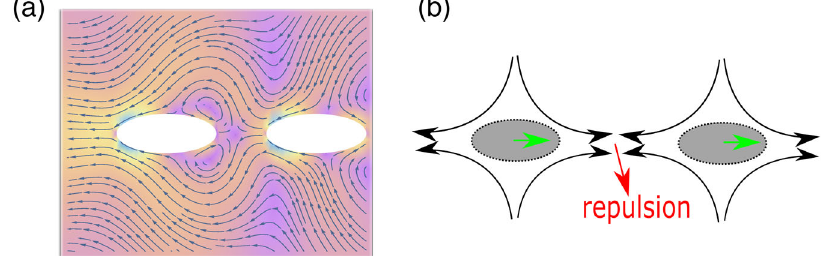
Fig. 8 Two swimmers in VELC, launching with the same initial orientation α = 0. Two pushers ( β = − 2) with planar anchoring ( W = 0.5) swim in VELC. Both of their initial orientation is α = 0. Coupling parameter χ = − 0.03. a Fluid velocity fi eld v ( x ) around the swimmers. b Sketch of the velocity fi eld showing that two pushers are repulsive when one follows the